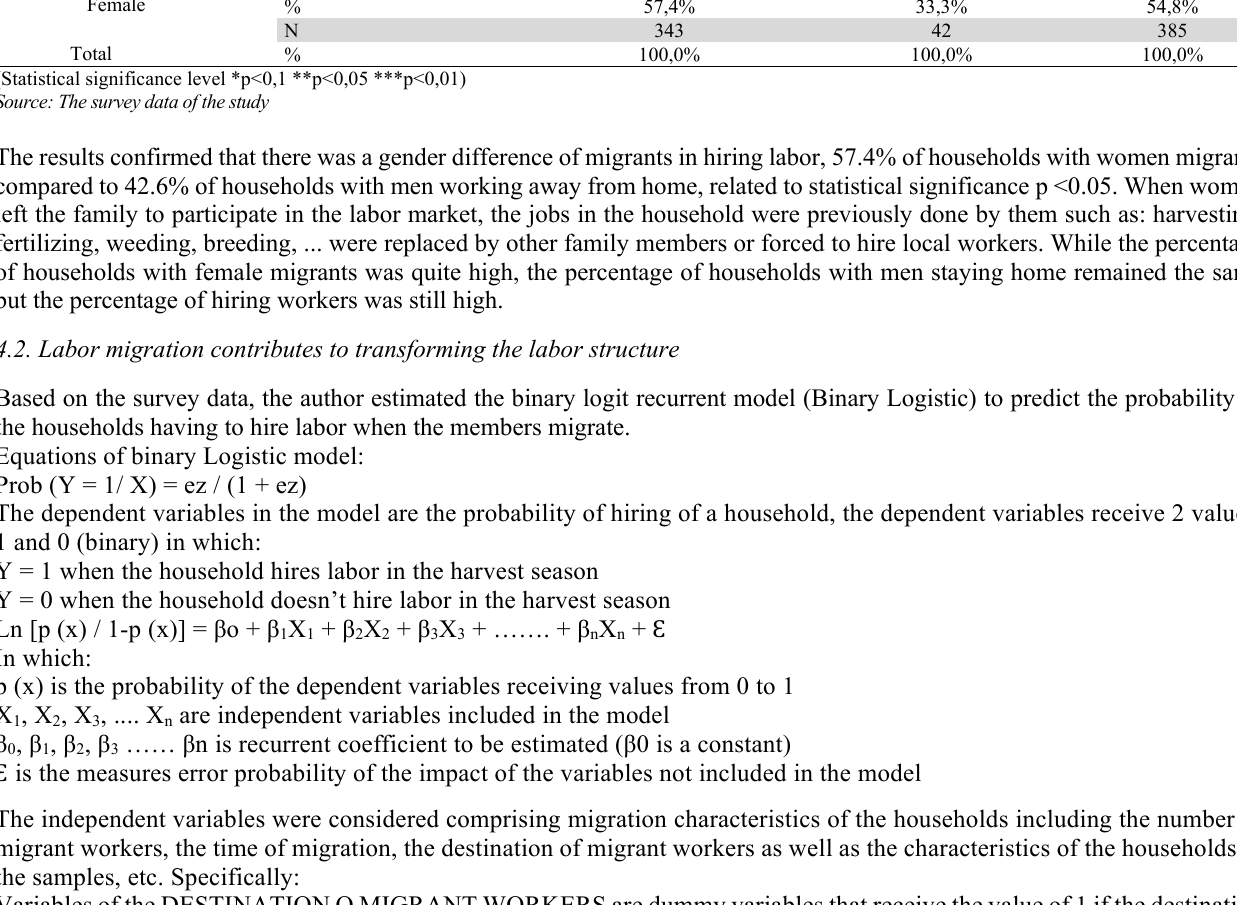
Percentage of households hiring workers by gender of migrant workers in 2 surveyed communes (Unit: %) Gender of migrants in 2015** Hiring situation % Hire % Non-hire N 146 28 174 Male % 42,6% 66,7% 45,2% N Female